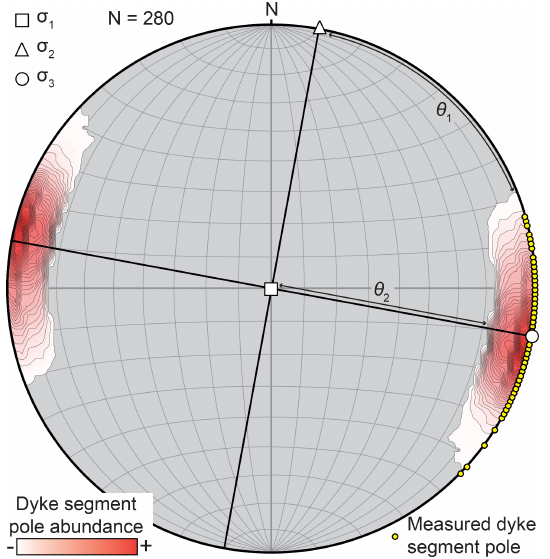
Figure 16. Equal-area lower-hemisphere stereographic projection of poles (yellow filled circles) to all measured VZD (dyke) seg- ments. Dyke pole data are contoured assuming a measured dip error of 10 ◦ ; data was plotted in Stereonet 10.0 and contoured using the Kamb contouring method with an interval of 1 and a significance level of 5. The minimum principal stress axis ( σ 3 ) was defined as the centre of the dyke pole cluster, with the geometry of the cluster used to distinguish which of the two orthogonal axes were σ 1 and σ 2 (Jolly and Sanderson, 1997).